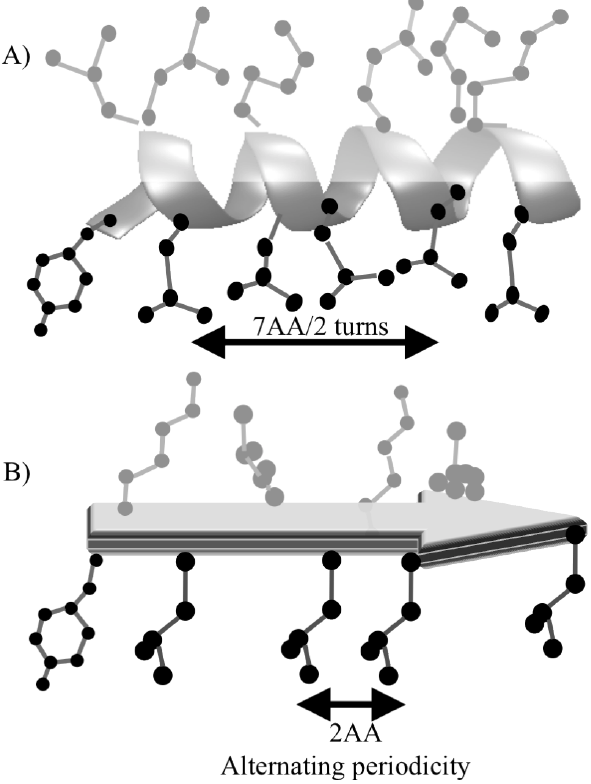
Figure 2. Peptide in α -helix ( A ) and β -sheet ( B ) conformation with polar side chains showed in gray color while non-polar in black color, AA: Amino acid. Amino acid sequence matches the periodicity requirement for α -helix and β -sheet making it amphiphilic (adapted from Xiong et al .